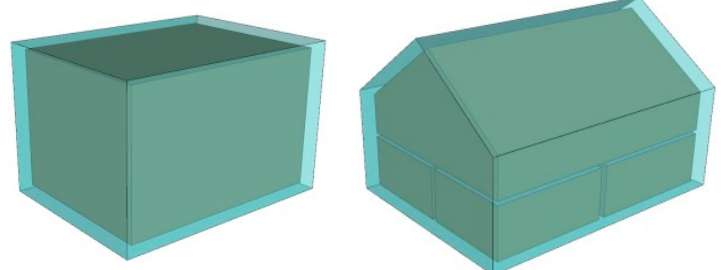
Figure 3. ILoD0, the coarsest representation of the building-interior model.